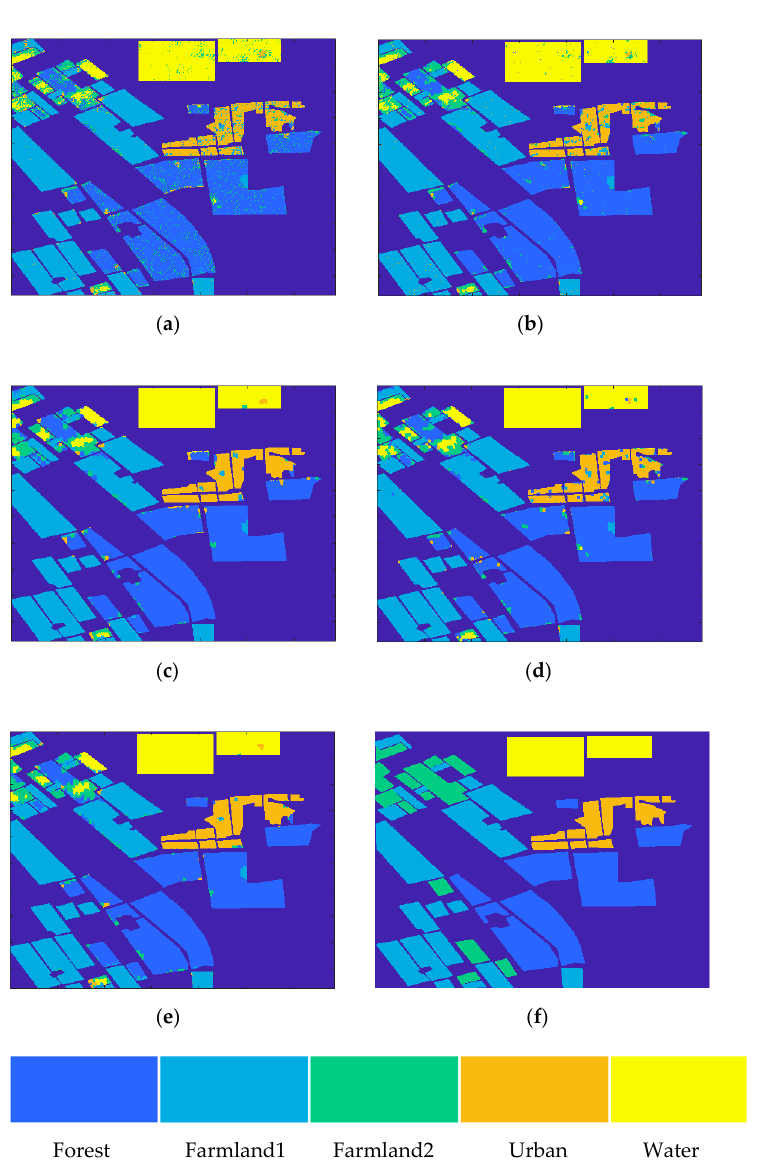
Figure 6. The classification results on the Flevoland image. ( a ) CNN. ( b ) CNN-MRF. ( c ) CNN-SP. ( d ) RCC-MRF. ( e ) Proposed method. ( f ) Ground truth. ( d ) RCC-MRF. ( e ) Proposed method. ( f ) Ground